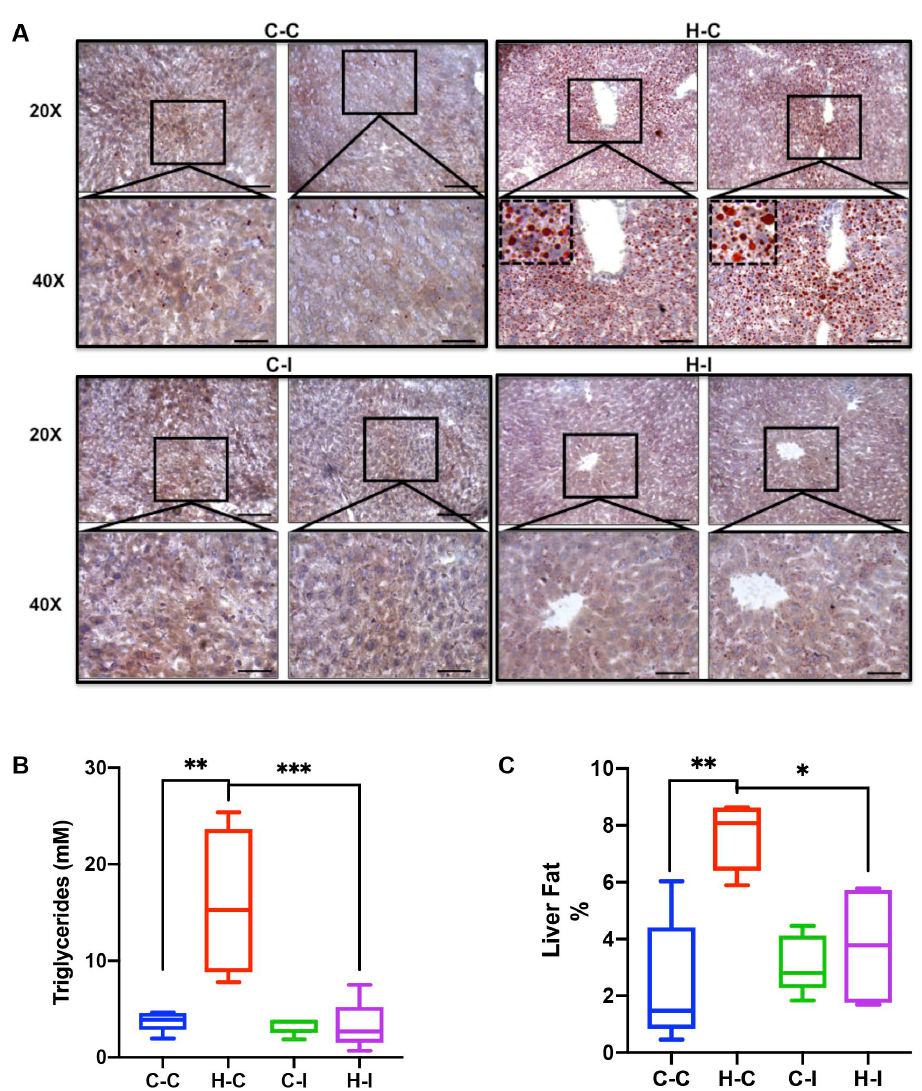
Figure 2. Inulin improves triglyceride accumulation on liver tissue after four weeks of treatment. ( A ) Liver histological sections were captured after Oil Red O staining as mentioned in materials and methods. Representative images from each group are showed for control groups without (C-C) or with inulin treatment (C-I), and fat-enriched groups (H-C and H-I). Micrographs show images of two mice-liver sections at 20× and magnifications of the squared regions at 40× below. The doted squares within 40× H-C group shows a 100× amplification of the corresponding image. ( B ) Boxplot showing the triglycerides concentration in liver tissue homogenates and ( C ) liver fat content in terms of percentage, for each diet group. * p < 0.05, ** p < 0.01 and *** p < 0.001, one-way ANOVA, Tukey’s test. Scale bar in panel A = 100 μm.